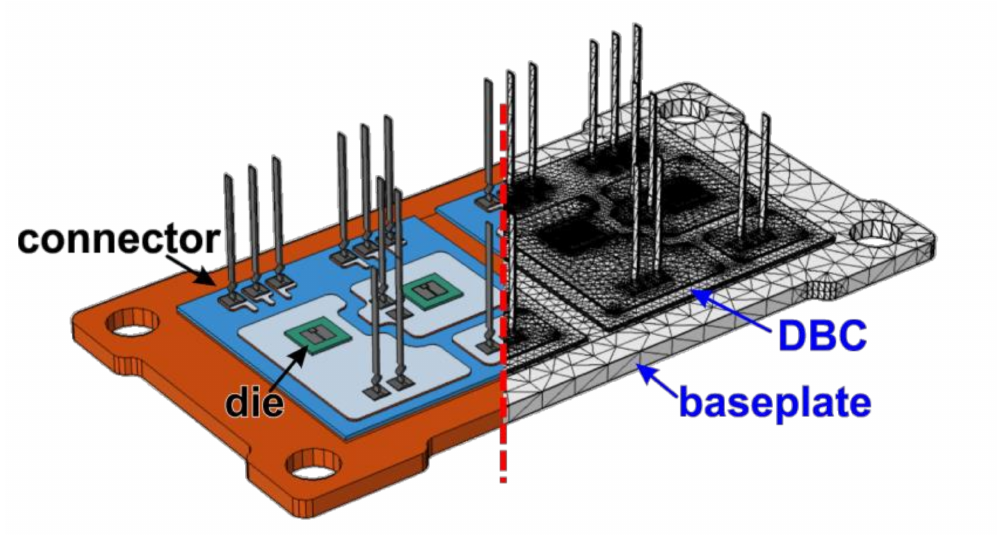
Figure 4. 3-D view of the PM geometry (left to the red dashed line) and tetrahedral mesh (right) automatically constructed in the COMSOL environment (the insulating gel is set as transparent for illustrative purposes). An exact replica of the real structure (Figure 1) was